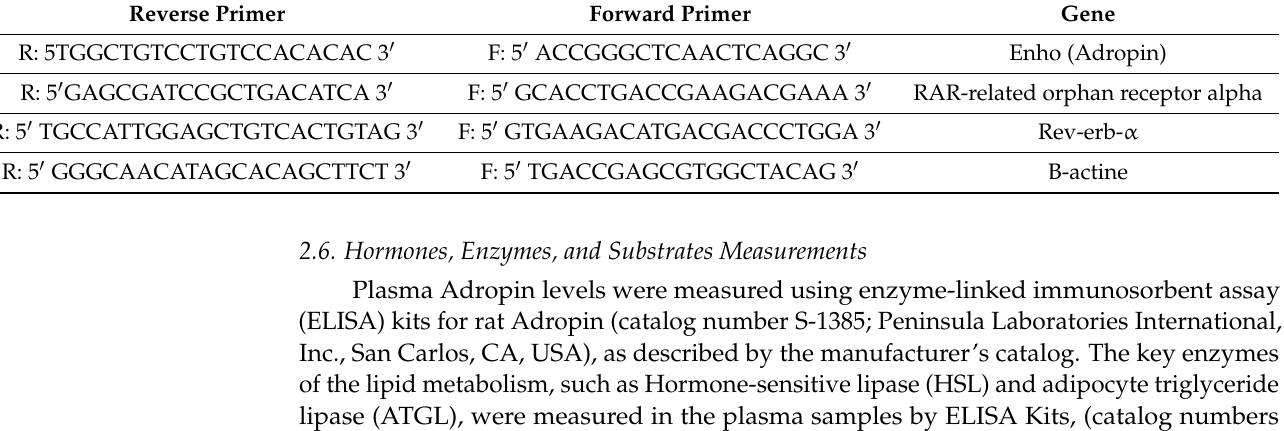
Table 1. Primer (Invitrogen, USA) sequences for the Enho, RAR-related orphan receptor alpha, Rev-Erb- α , and B- actine genes. Reverse Primer Forward Primer